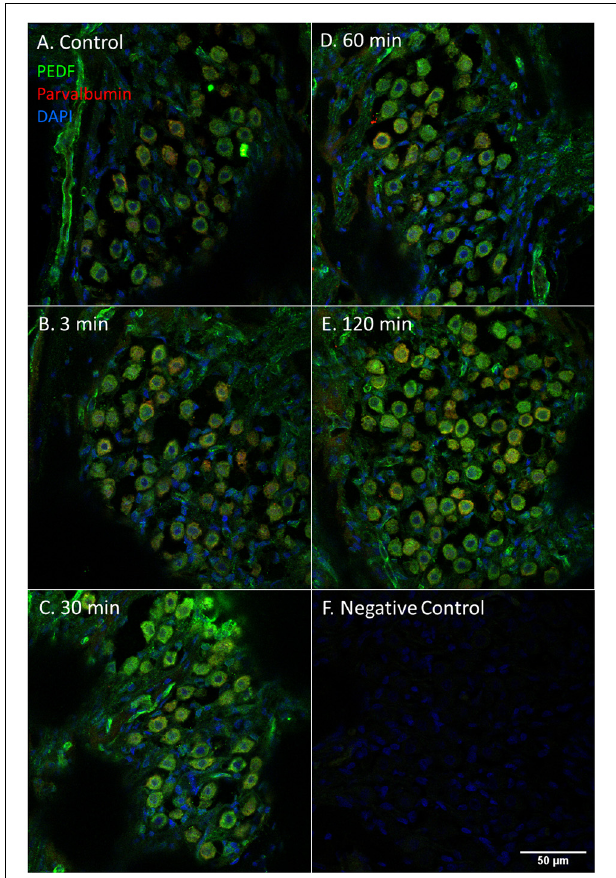
FIGURE 8 | PEDF in the spiral ganglion following furosemide injection. (A–F) PEDF protein staining of guinea pig spiral ganglion following IV furosemide injection. (A) In the control was PEDF localized in the cytoplasm of the spiral ganglion type I neurons. (B–E) The staining intensity after furosemide at the different intervals. (F) Negative control.